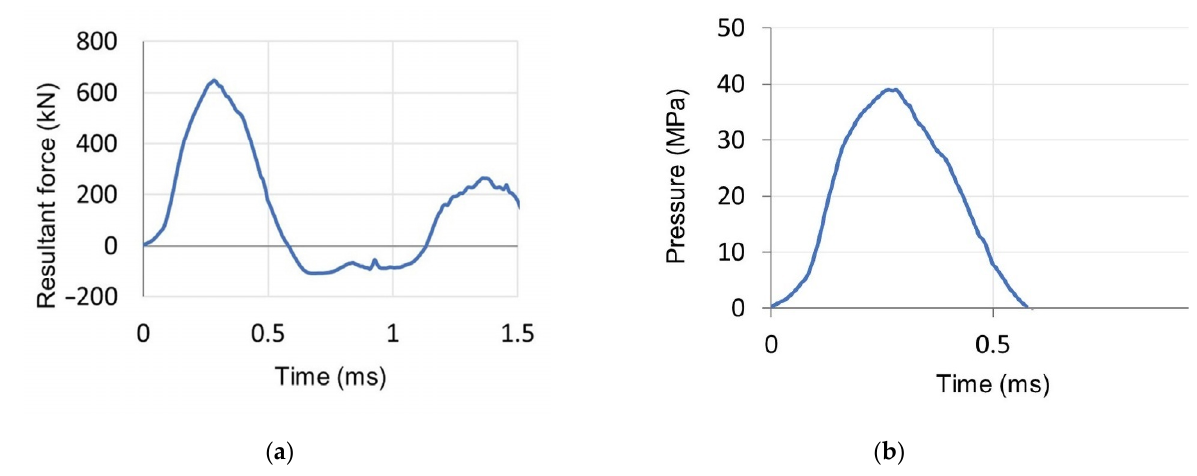
Figure 21. Resultant force ( a ) and pressure ( b ) recorded during shot no. 9.